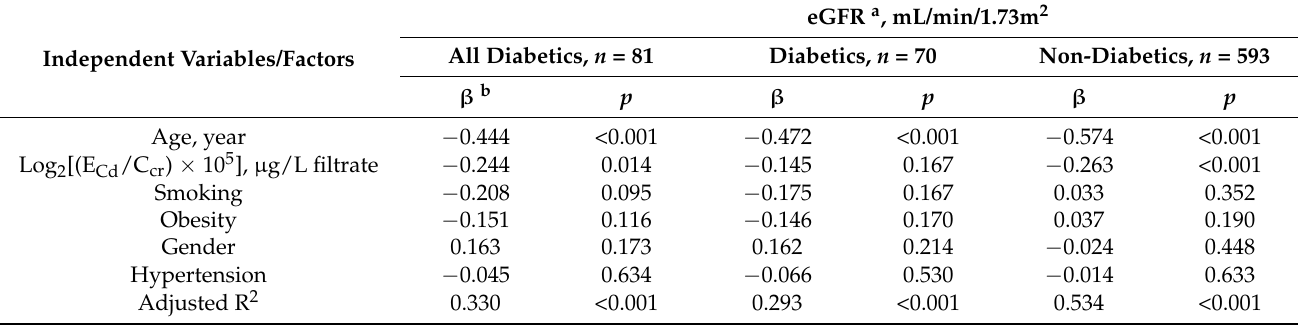
Table 4. Associations of eGFR with cadmium excretion and other independent